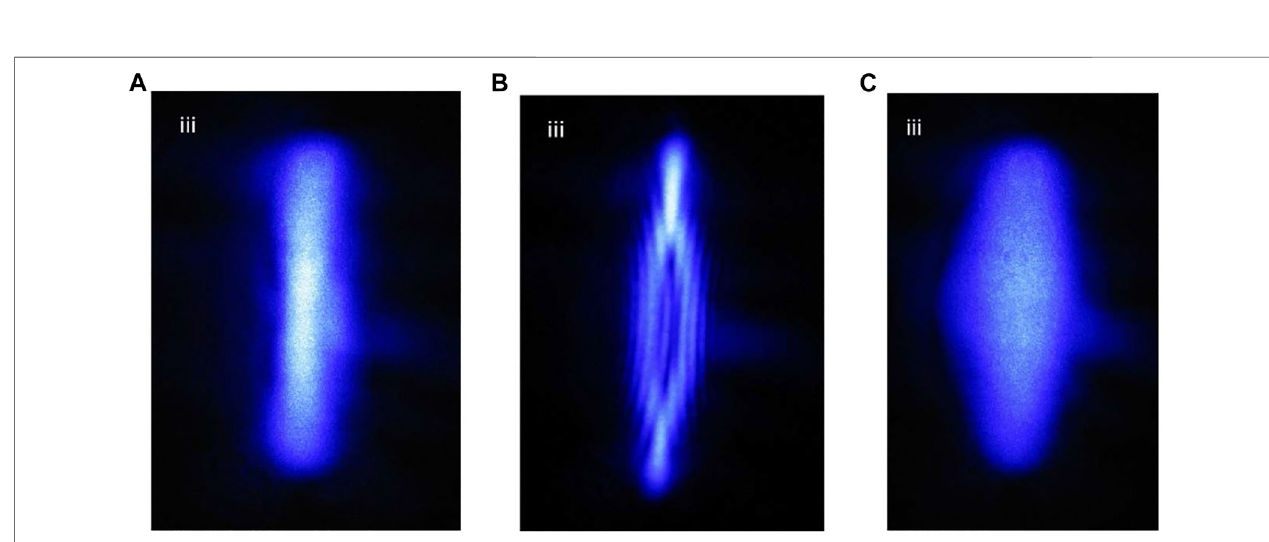
FIGURE10| Viewsoftheintensitydistribution after passing thecuvette Cwithsuspendedparticles,fordifferentpositionsofthecuvette: (A) thecuvette issituated immediately behind the CL, (B) the cuvette is placed at 350 μ m before the focal plane of the CL, (C) the cuvette is placed far behind the focal plane.